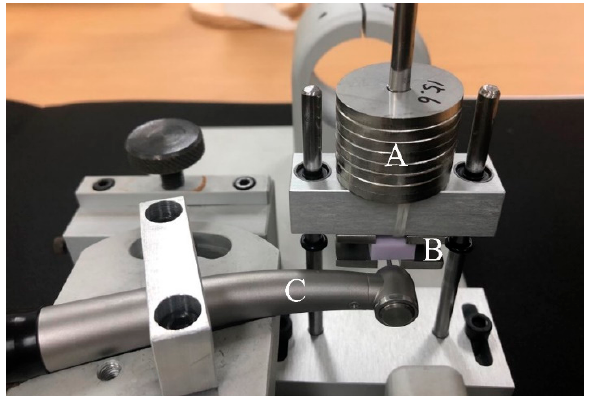
Figure 3. The experimental custom-made device: A. weight for constant load, B. specimen, C. high-speed handpiece.